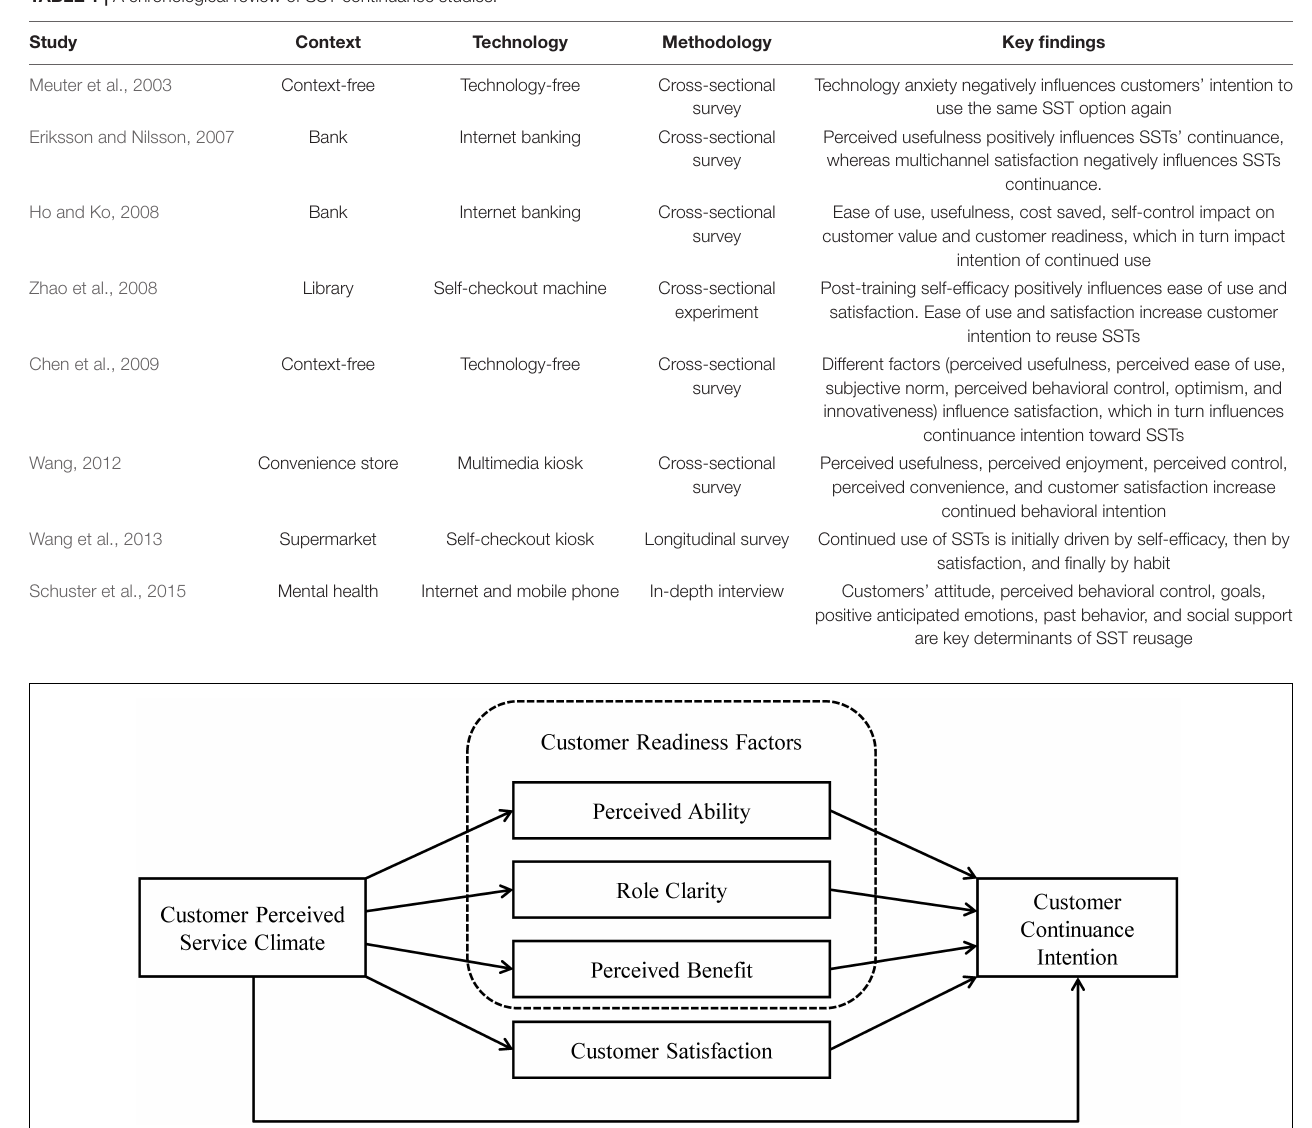
TABLE 1 | A chronological review of SST continuance studies.